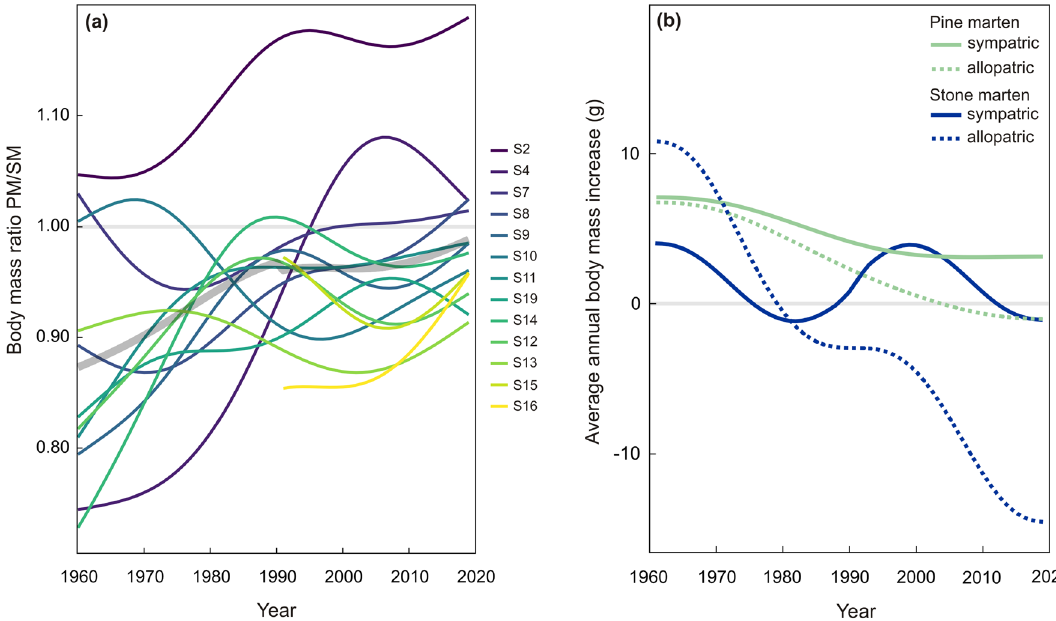
Figure 4. Changes of the ratio between pine marten (PM) and stone marten (SM) body mass in Europe over 59 years ( a ); bold grey line represents body mass ratio PM/SM averaged for sites. Mean annual predicted body mass increase averaged for sympatric and allopatric sites ( b ). Stone marten allopatric area was represented by one site in southern Spain (S1); site’s location in Fig.